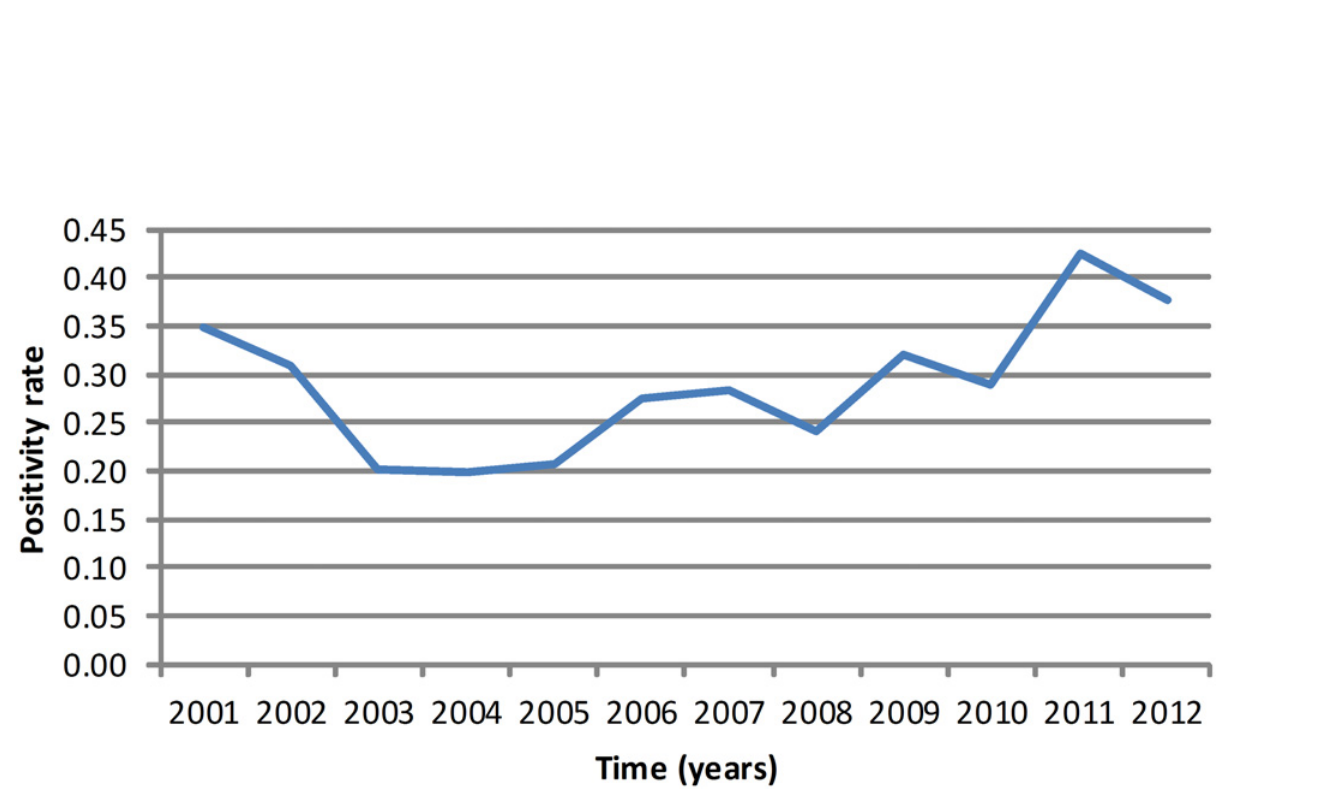
Fig 7. Overall trend of the positivity rates for animal rabies diagnoses in Minas Gerais State, Brazil, from 2001 to 2012.